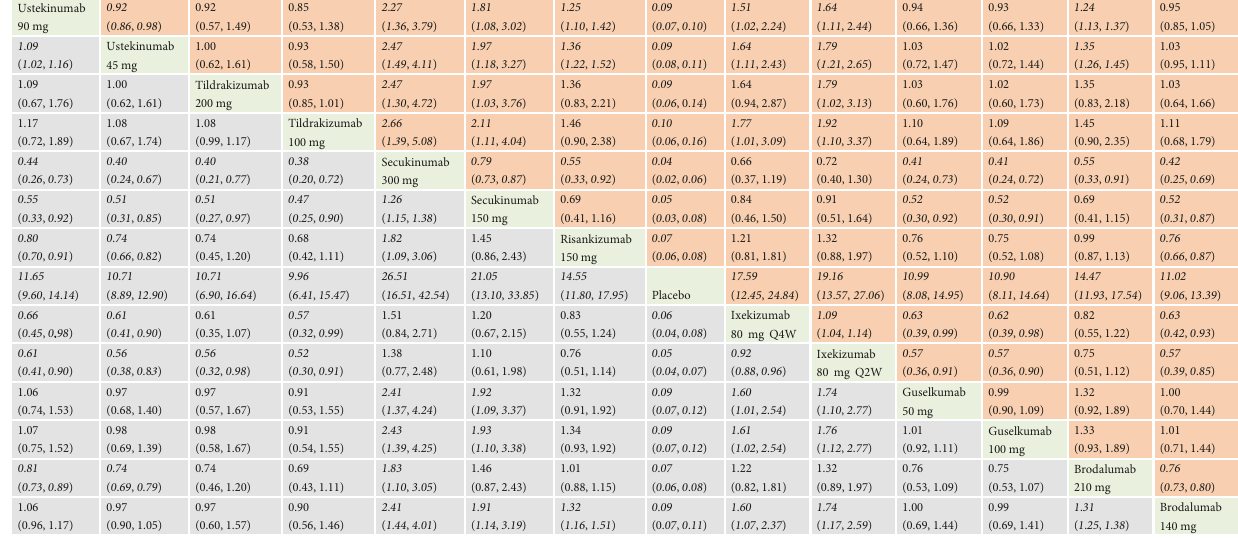
Figure 6: Relative risk with 95% CIs of all interventions from network meta-analysis for sPGA 0/1 or IGA 0/1 or PGA 0/1 responses. Di ff erent interventions in the middle block divide the graph into upper and lower triangles; for the lower triangle, the e ffi cacy estimate is the ratio of the column de fi ning treatment to the row de fi ning treatment. In case that the con fi dence interval does not include 1, if RR > 1 , it favors the column de fi ning treatment. In contrast, if RR < 1 , it favors the row de fi ning treatment. The upper triangle is symmetrical to the lower triangle. The e ffi cacy estimate is the ratio of the row de fi ning treatment to the column de fi ning treatment. The results are mutually reciprocal. Statistically signi fi cant results have been applied with italic formatting.